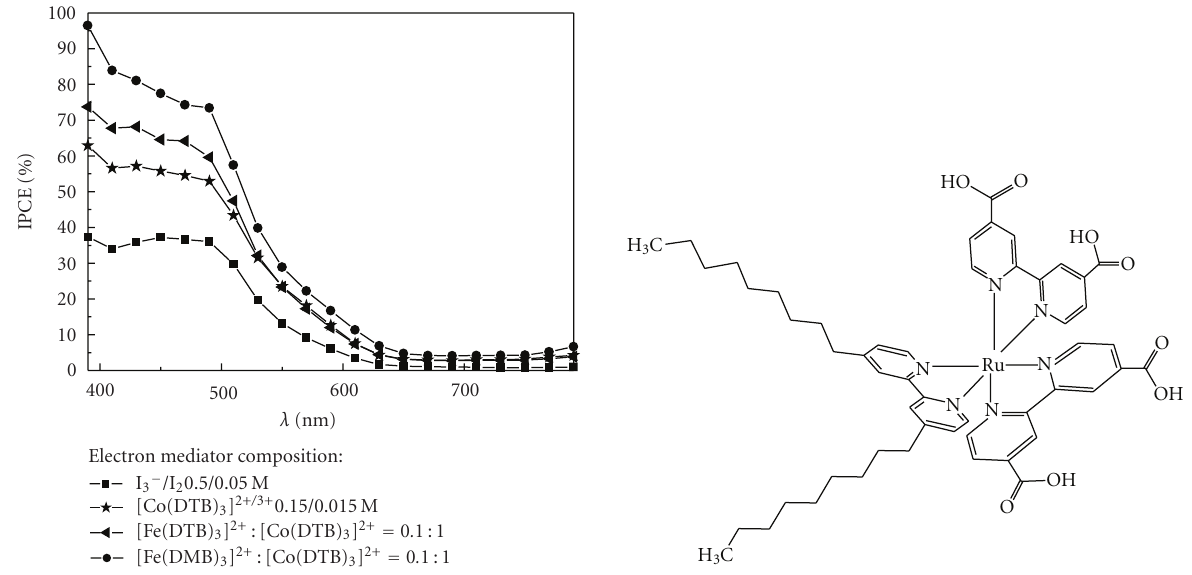
Figure 15: IPCE spectra of Ru(dnbpy) (H 2 DCB) 2+